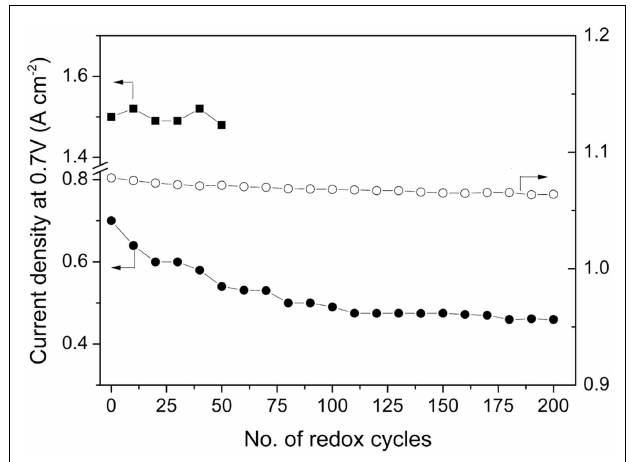
FIGURE 10 | OCV(open circles) and current density at 0.7V (closed circles) as a function of the number of redox cycles (10min in H 2 and 10min in air) at 750°C as well as current density at 0.7V (closed squares) as a function of the number of redox cycles at 800°C applying 2h in H 2 and 10min in air (Ma et al., 2010) . Reprinted with permission from Elsevier.